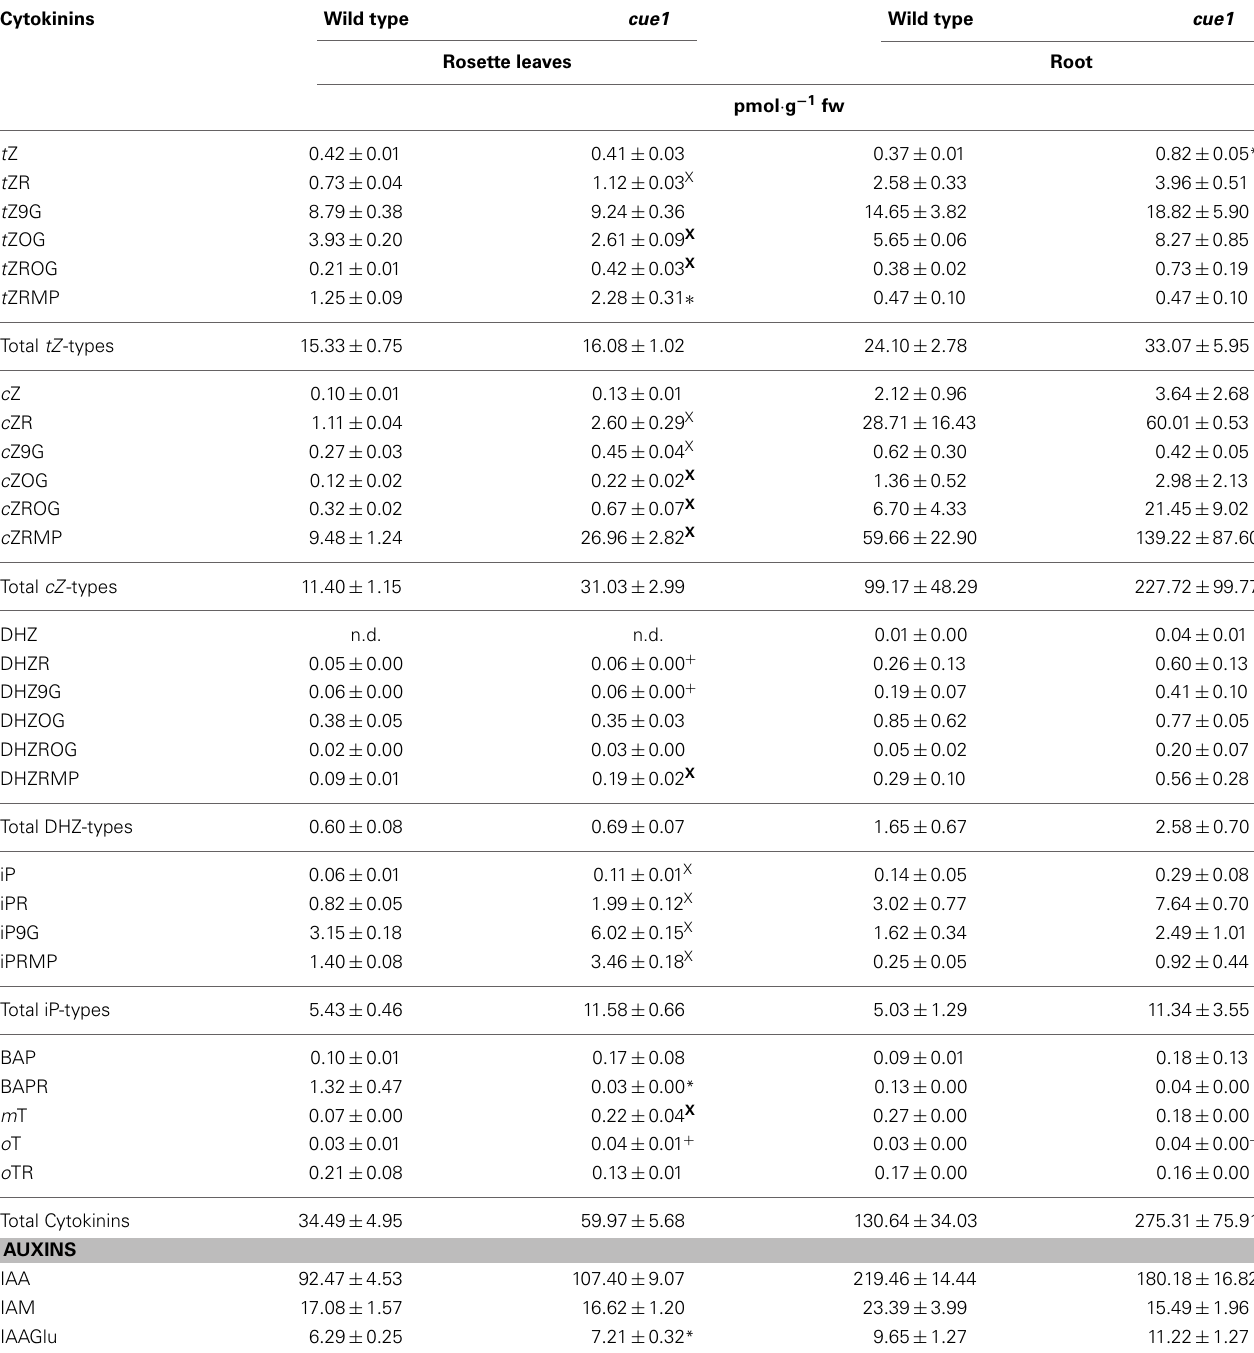
Table 1 | Contents of cytokinin and auxin metabolites in cue1 rosette leaves and roots.